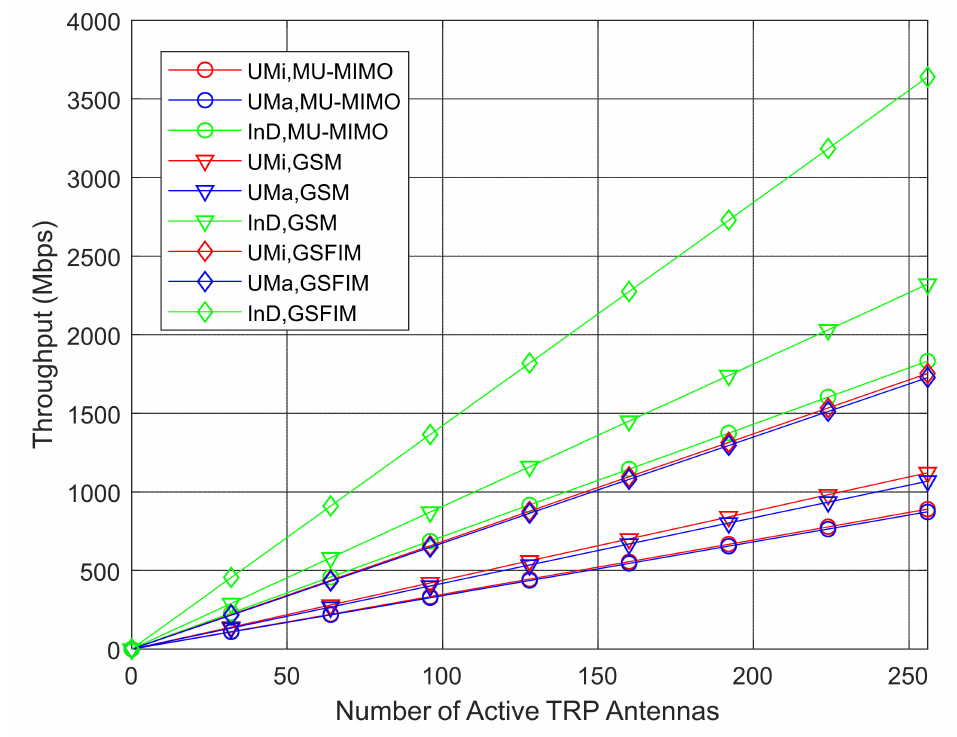
Figure 13. Throughput vs. number of active TRP antennas, RAN cluster size 3, for different systems and scenarios, with N tx /N u = 12, N sc = 256, N a = 2, N rx = 5, 12 bpcu, GSM and MU-MIMO with 64QAM and GSFIM with 16QAM N f = 16, N af = 13.